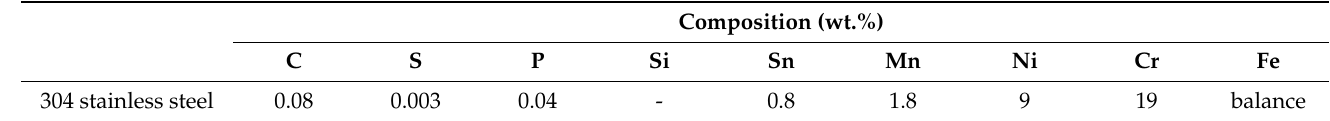
Table 1. Chemical composition of the 304 stainless